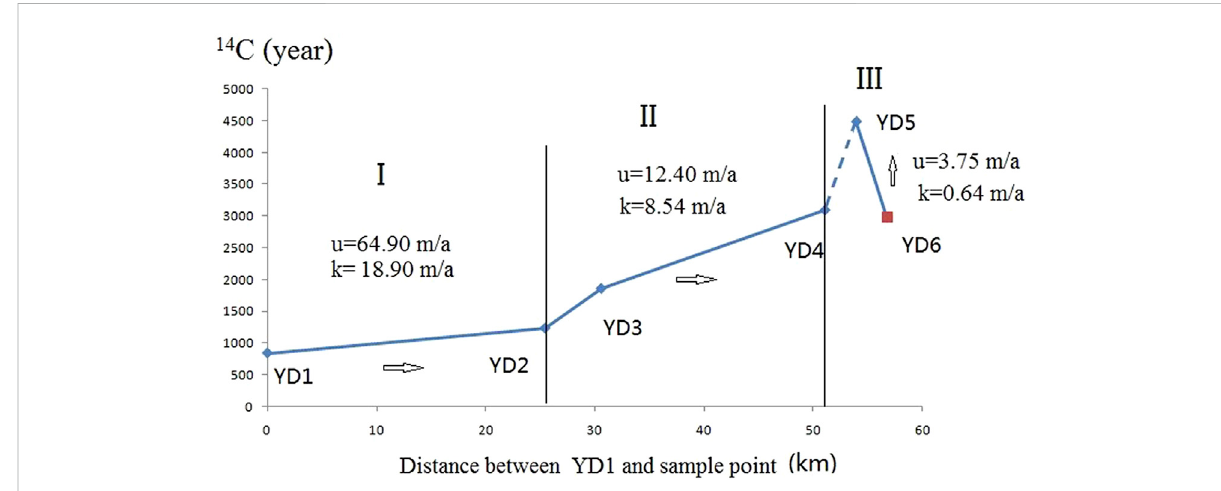
FIGURE 8 Zonality characteristics of groundwater fl ow velocity and aquifer permeability along the typical pro fi le (I, II, and III indicates the upper part, middle part, and bottom part of the pluvial – alluvial fan, respectively; u is the water- fl ow velocity, and k is the permeability